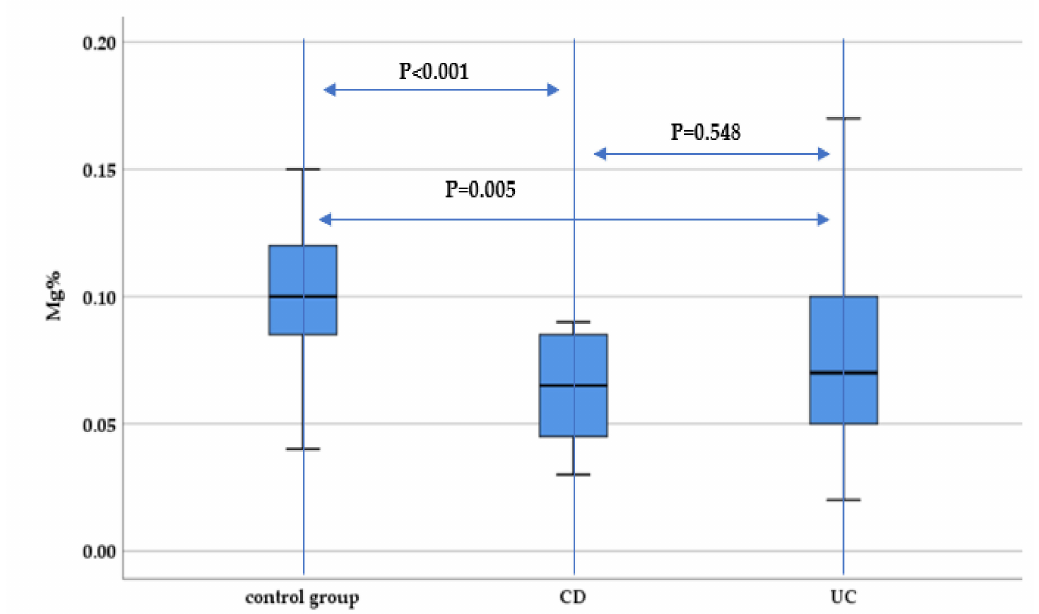
Figure 1. Evaluation of hair magnesium concentration (Mg%) between IBD subtypes (UC and CD) and the control group.